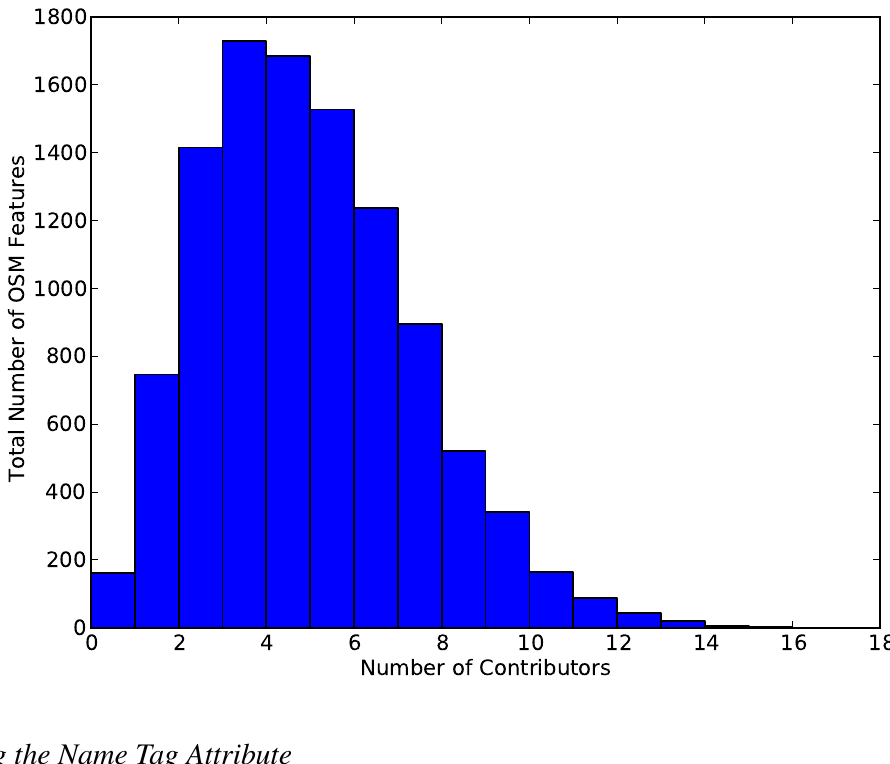
Figure 2. The distribution of the number of unique contributors to each geographic object in our OSM study